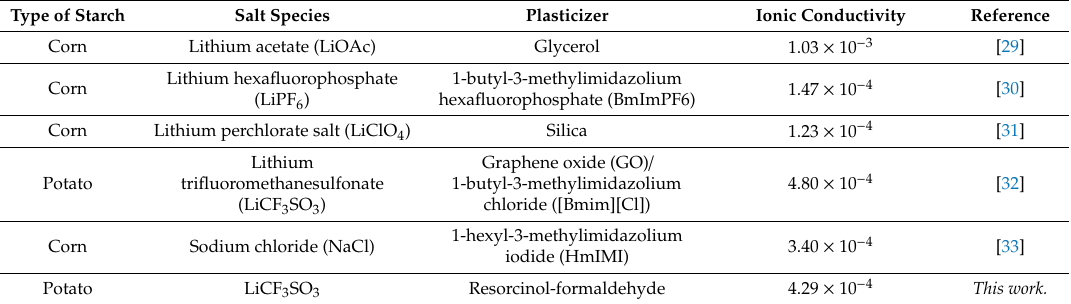
Table 3. Comparison of recent literature on plasticized starch-based polymer electrolytes. Type of Starch